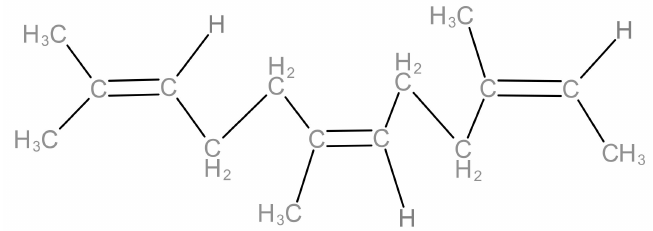
Figure 1. Natural rubber structure.